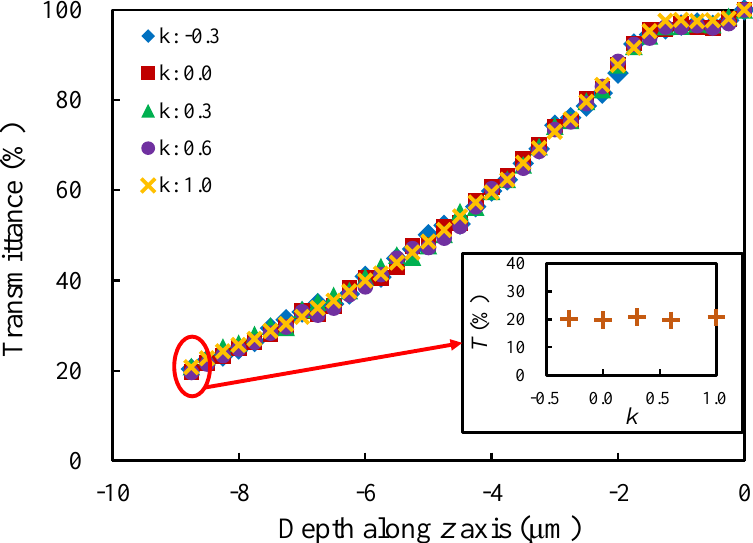
Figure 14. Evolution of the transmittance with the depth along z axis for the models with different normalized